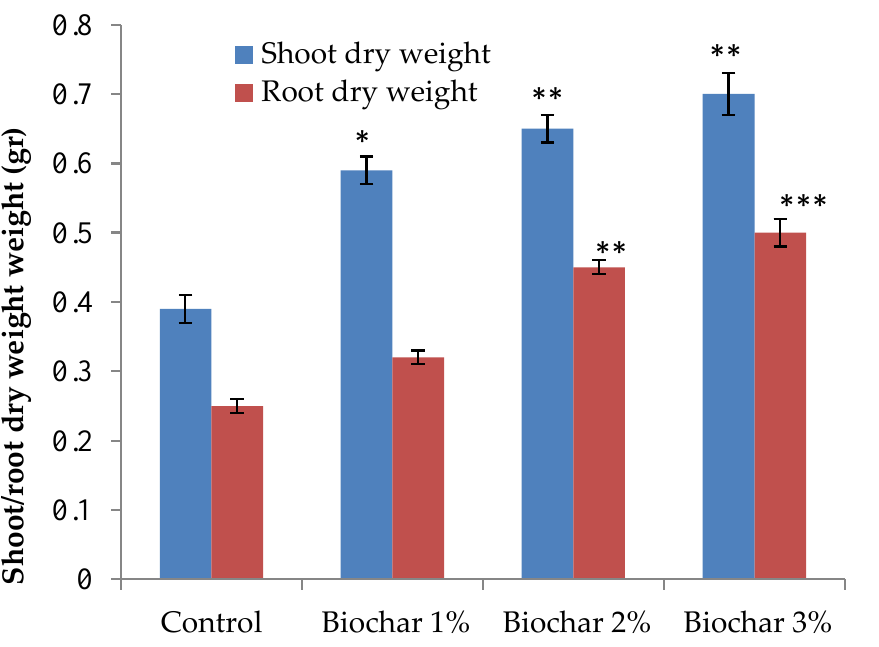
Figure 2. The impact of biochar concentrations on shoot and root dry weight of ginger. Data are means of three replicates ( n = 3), asterisks indicate significant differences from the control at p < 0.05, <0.01, <0.001.